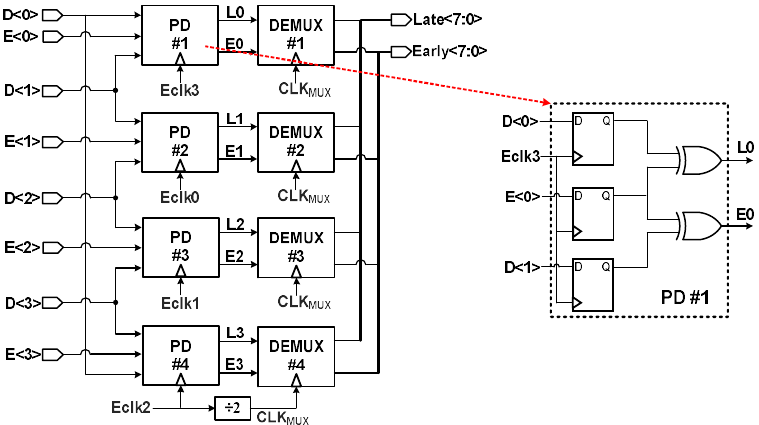
Figure 6. Block diagram of the E / L detector and the bang-bang PD.